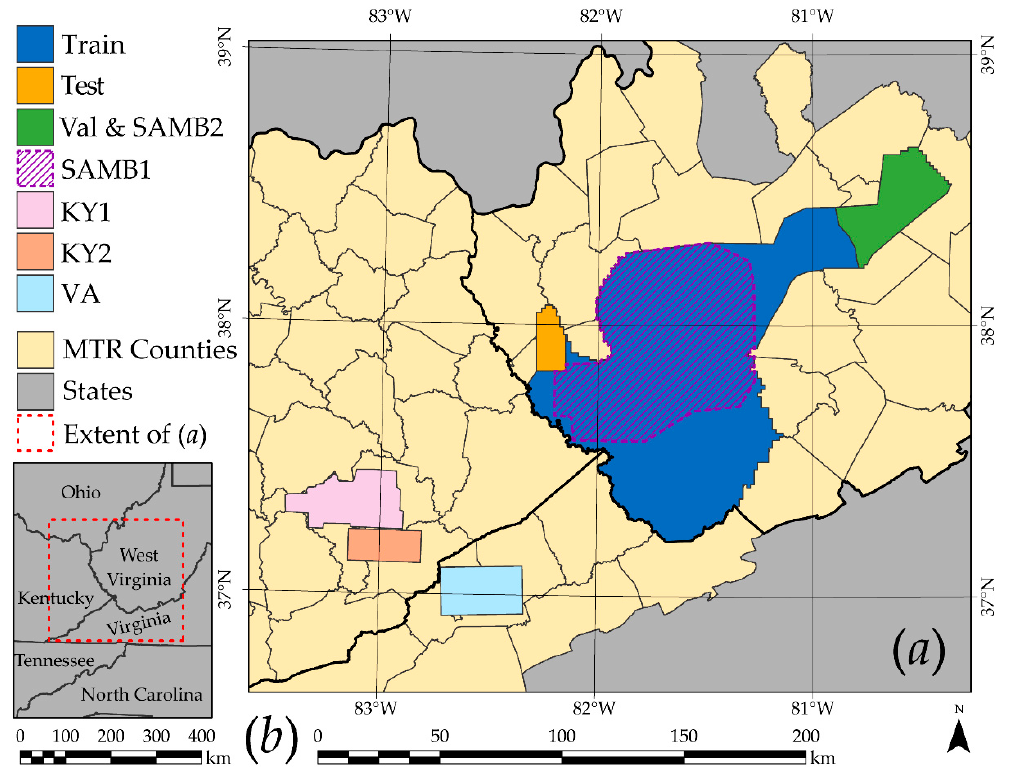
Figure 2. ( a ) Study areas in West Virginia, Kentucky, and Virginia in the Appalachian region of the eastern United States. ( b ) shows the extent of ( a ) in the eastern United States. Table 1. Description of study areas and mapped VFFs.